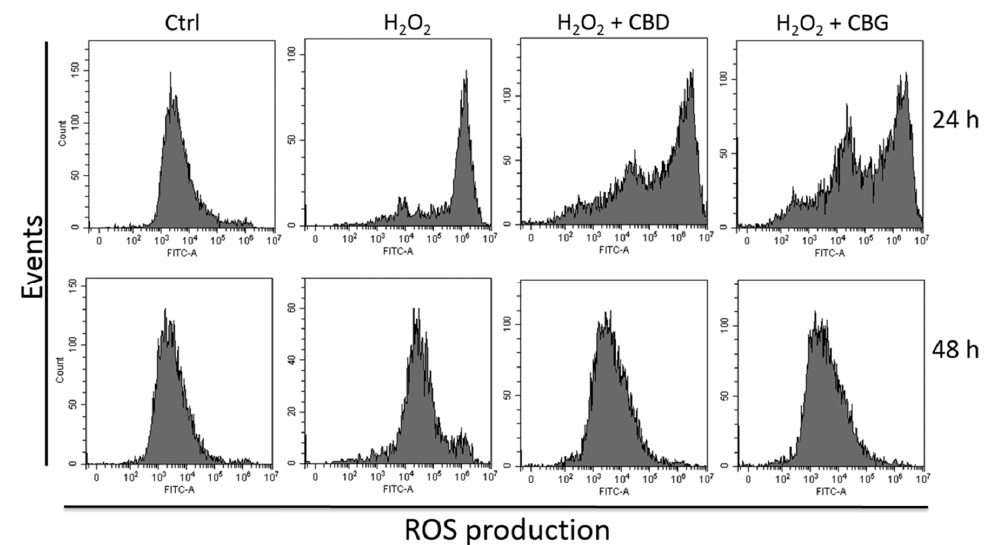
Figure 2. Reactive oxygen species (ROS) production in CTX-TNA2 astrocyte cell line exposed to 1000 nM CBD and 1 nM CBG and challenged with H 2 O 2 for 24 and 48 h. One representative experiment out of three independent experiments is shown ( n = 3).